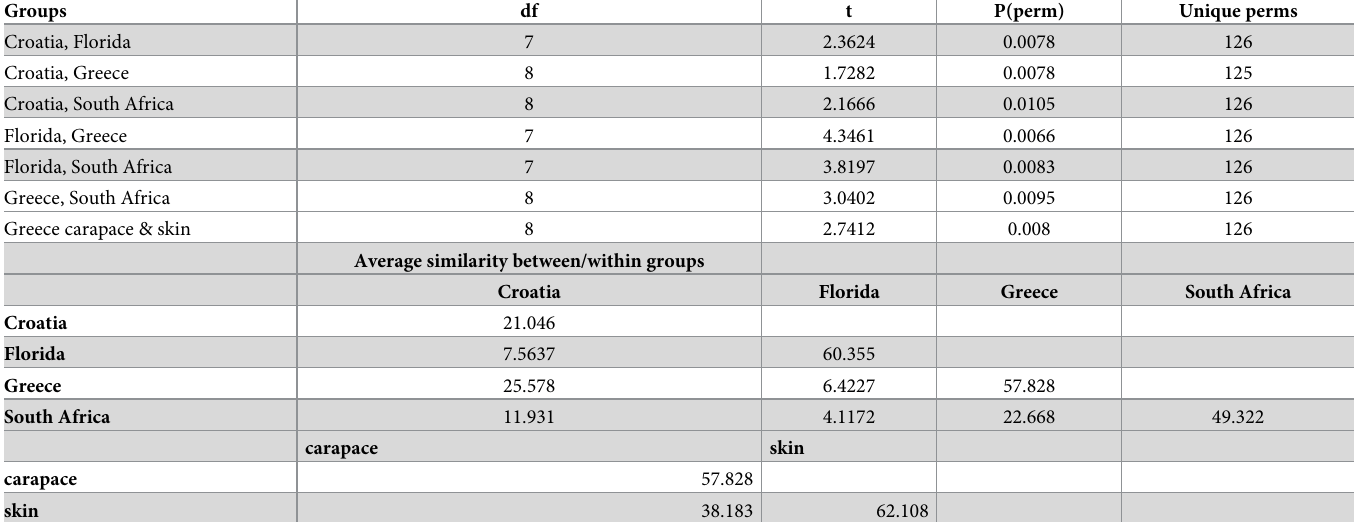
Table 5. PERMANOVA analyses based on pairwise tests on square-root transformed data Sums of squares type: Type III (partial), fixed effects sum to zero for mixed terms. Groups